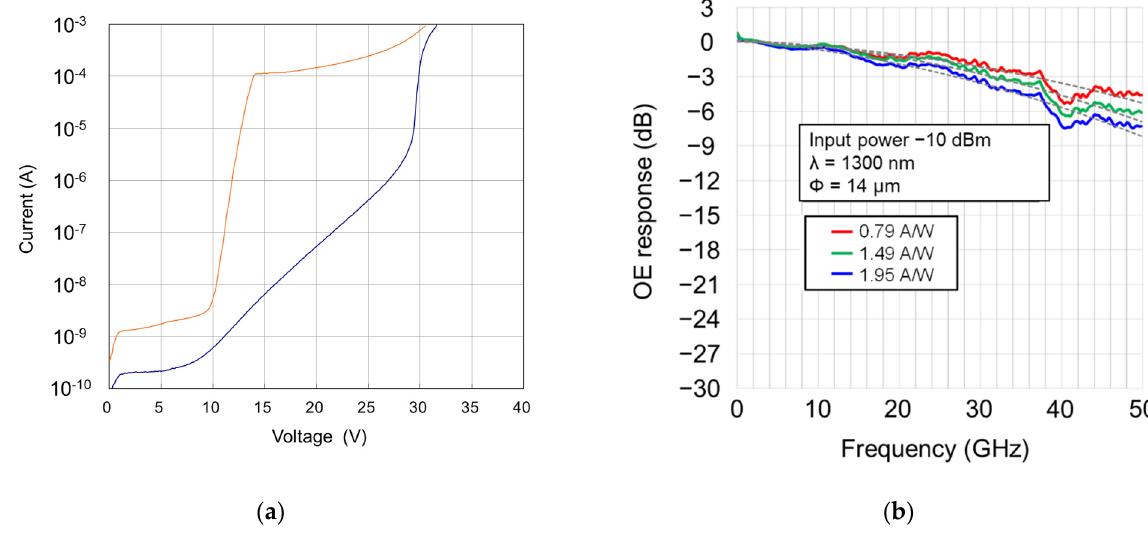
Figure 8. ( a ) Current-voltage (I-V) characteristics and ( b ) frequency characteristics of fabricated inverted p-down avalanche photodiodes (APD).